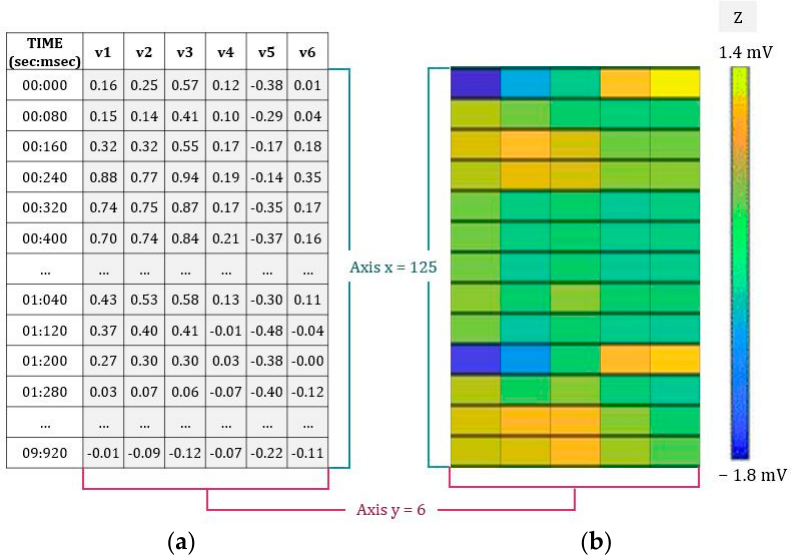
Figure 4. Explanation of sECG image formation: ( a ) Example of 125 numerical data; records taken every 80 ms. ( b ) Representation of the sECG image.